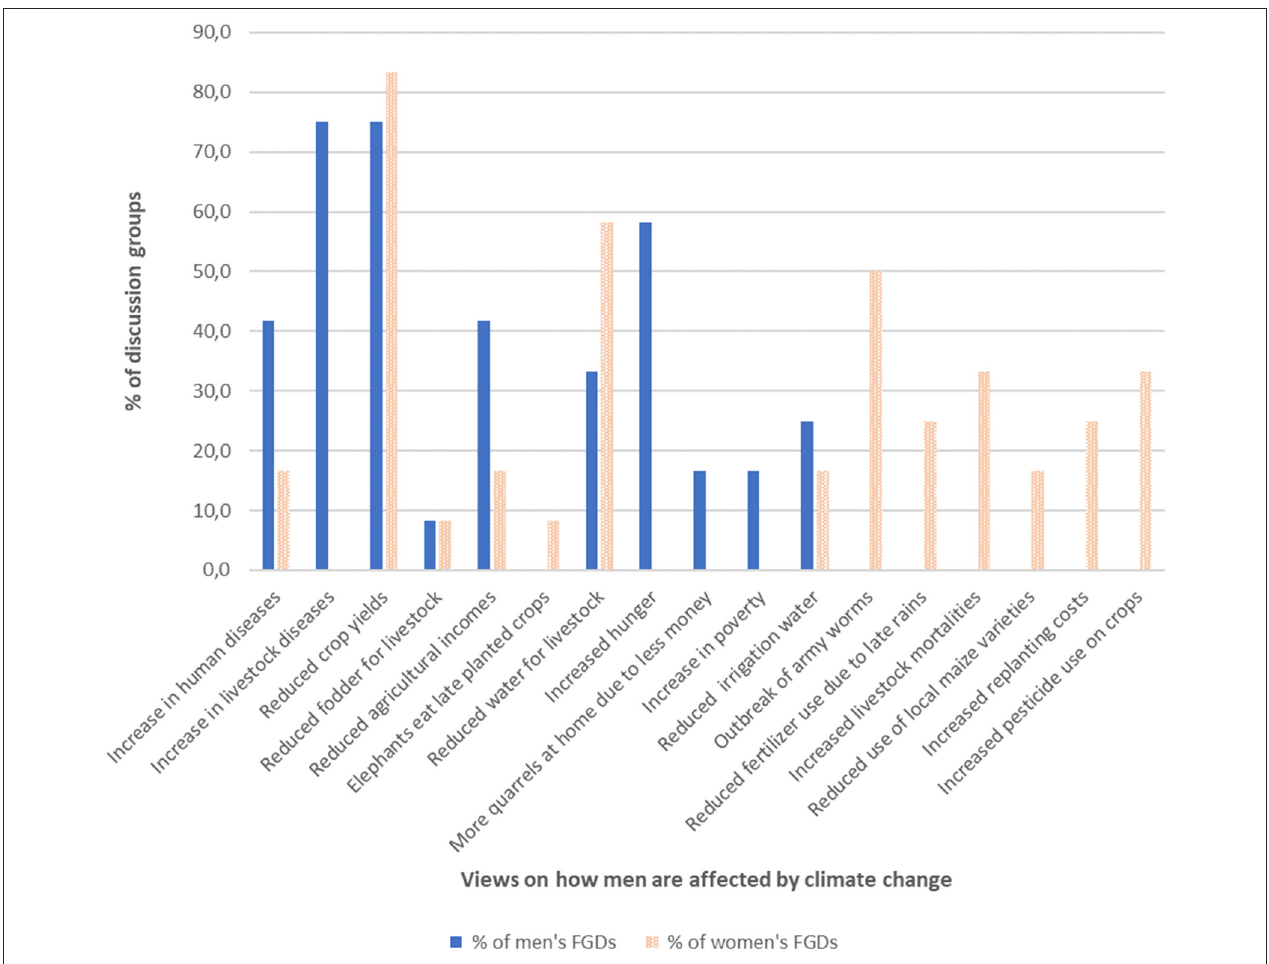
FIGURE 5 | FGDs’ views on how climate change affects